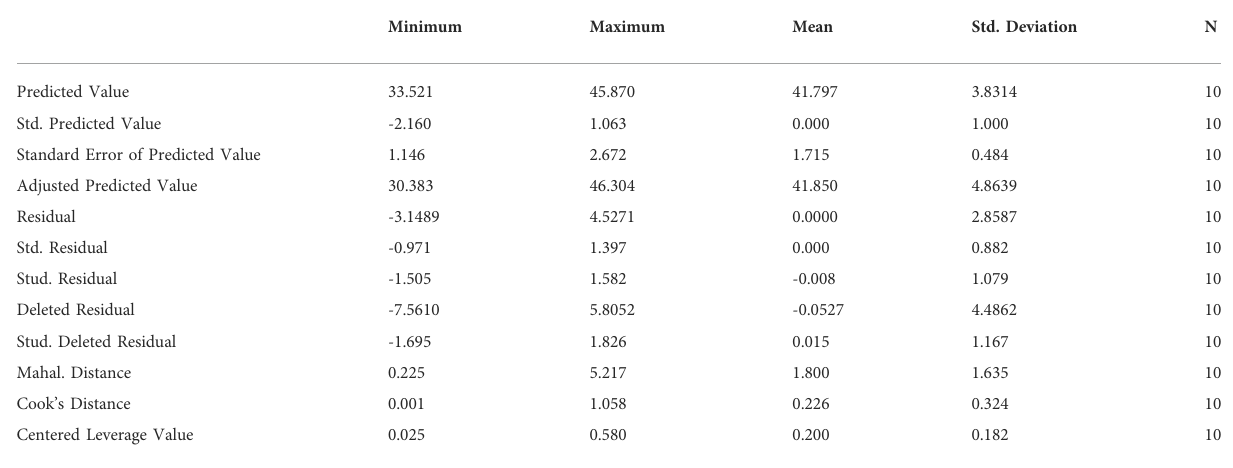
TABLE 4 Residual